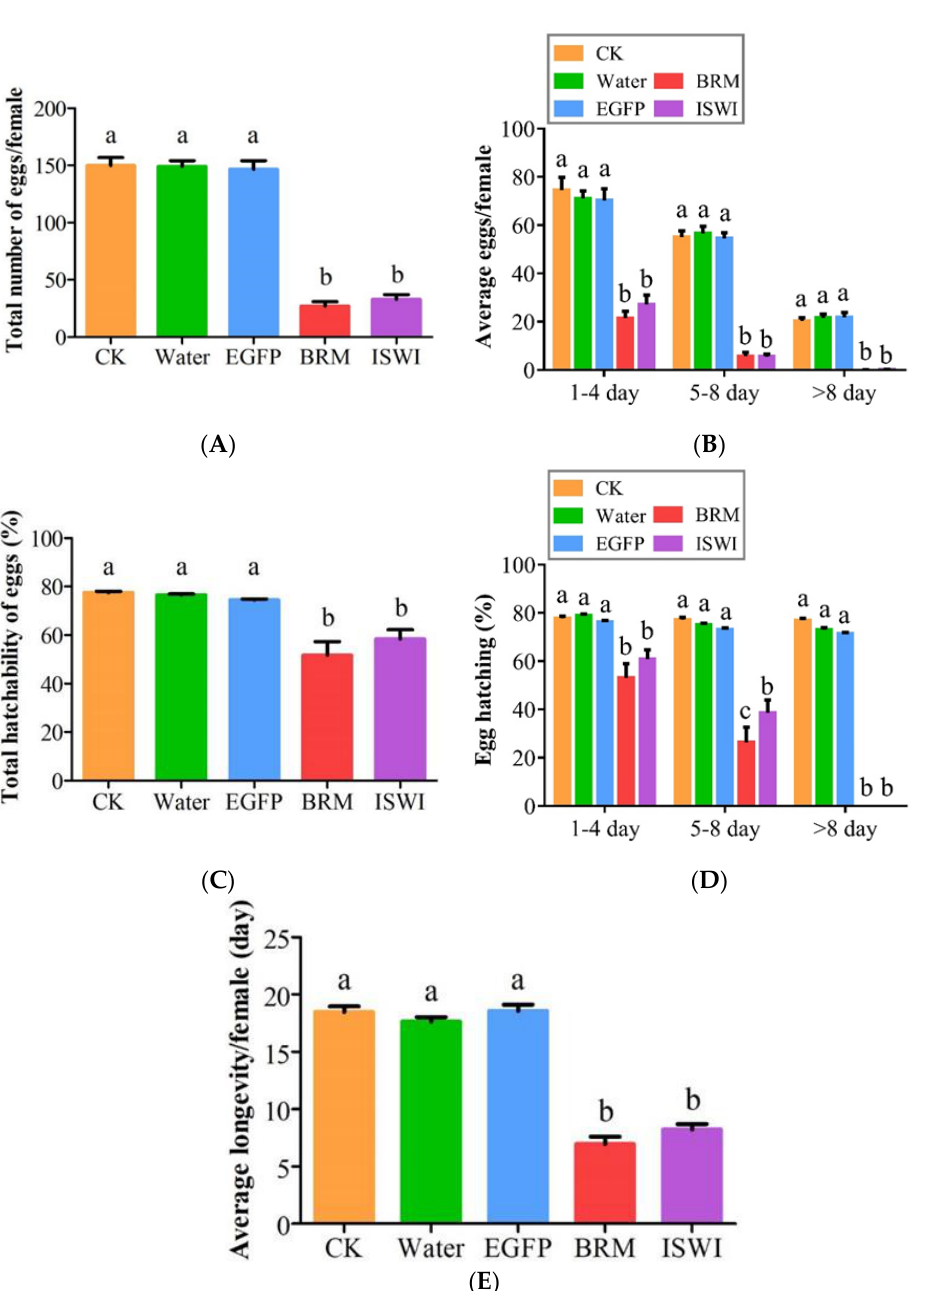
Figure 5. Effects of ds ISWI and ds BRM on Tuta absoluta oviposition, hatching, and longevity. ( A ) Average number of eggs laid per female at 1 – 4 d, 5 – 8 d, and > 8 d. ( B ) Total oviposition per female. ( C ) Percentage of eggs hatched at 1 – 4 d, 5 – 8 d, and > 8 d. ( D ) Total egg hatchability. ( E ) Average longevity of injected F0 females. Controls consisted of uninjected female pupae (CK) and those injected with water or EGFP dsRNA. Data are means ± SEM. Bars with different lowercase letters indicate significant differences between treatment means at p < 0.05.